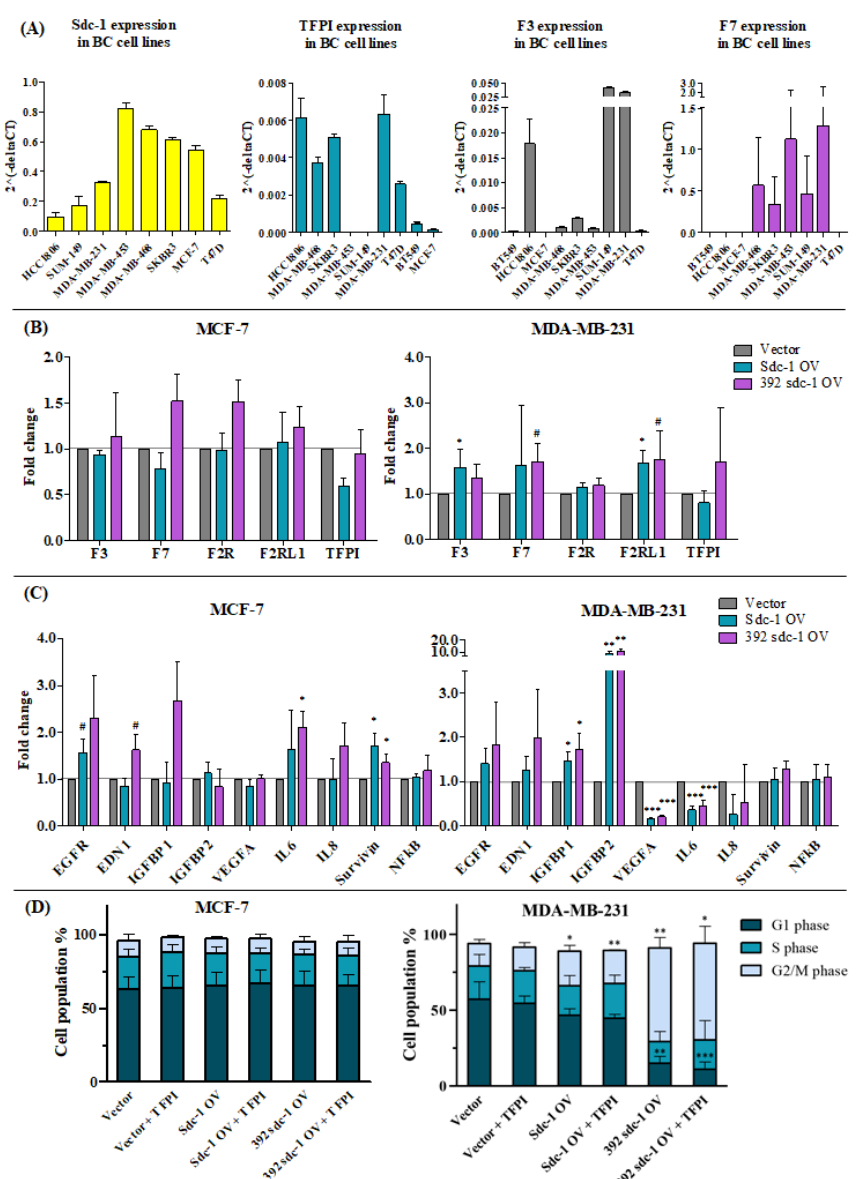
Figure 4. Sdc-1 overexpression has a differential effect on the tissue factor pathway (TF, F7, F2R, F2RL1, and TFPI) and cell-cycle progression in MCF-7 and MDA-MB-231 breast cancer cells. ( A ) Relative expression of Sdc-1, TFPI, TF, and F7 was quantified via qPCR in nine breast cancer cell lines, representative of the basal (MDA-MB-231, -468, -453, and BT549), luminal (T47D, SUM-149, and MCF-7 (WT status for p53)), and HER2-enriched (SKBR3 and BT-474) subtypes. Individual experiments were normalized against β -ACTIN and the relative expression was represented by means of 2- Δ Ct. ( B , C ) The expression of tissue factor pathway-associated genes was analyzed in Sdc-1-OV and 392-Sdc-1-OV breast cancer cells by means of qPCR, normalized to β -actin expression, and shown as a fold change (n = 3). The left and right panels represent the MCF-7 and MDA-MB-231 cell lines, respectively. Data are presented as bar plots and means are represented with lines. Bars with asterisks represent comparisons with statistically significant differences (# p < 0.08, * p < 0.05, ** p < 0.01, *** p < 0.001). ( D ) The cell-cycle phase composition of Sdc-1-overexpressing MCF-7 and MDA-MB-231 cells was measured via DAPI staining and flow cytometry after 48 h of 50 µg/mL TFPI treatment (n = 4). Data are presented as bar plots and means are represented with lines. Bars with asterisks represent comparisons with statistically significant differences (* p < 0.05, ** p < 0.01, *** p < 0.001).